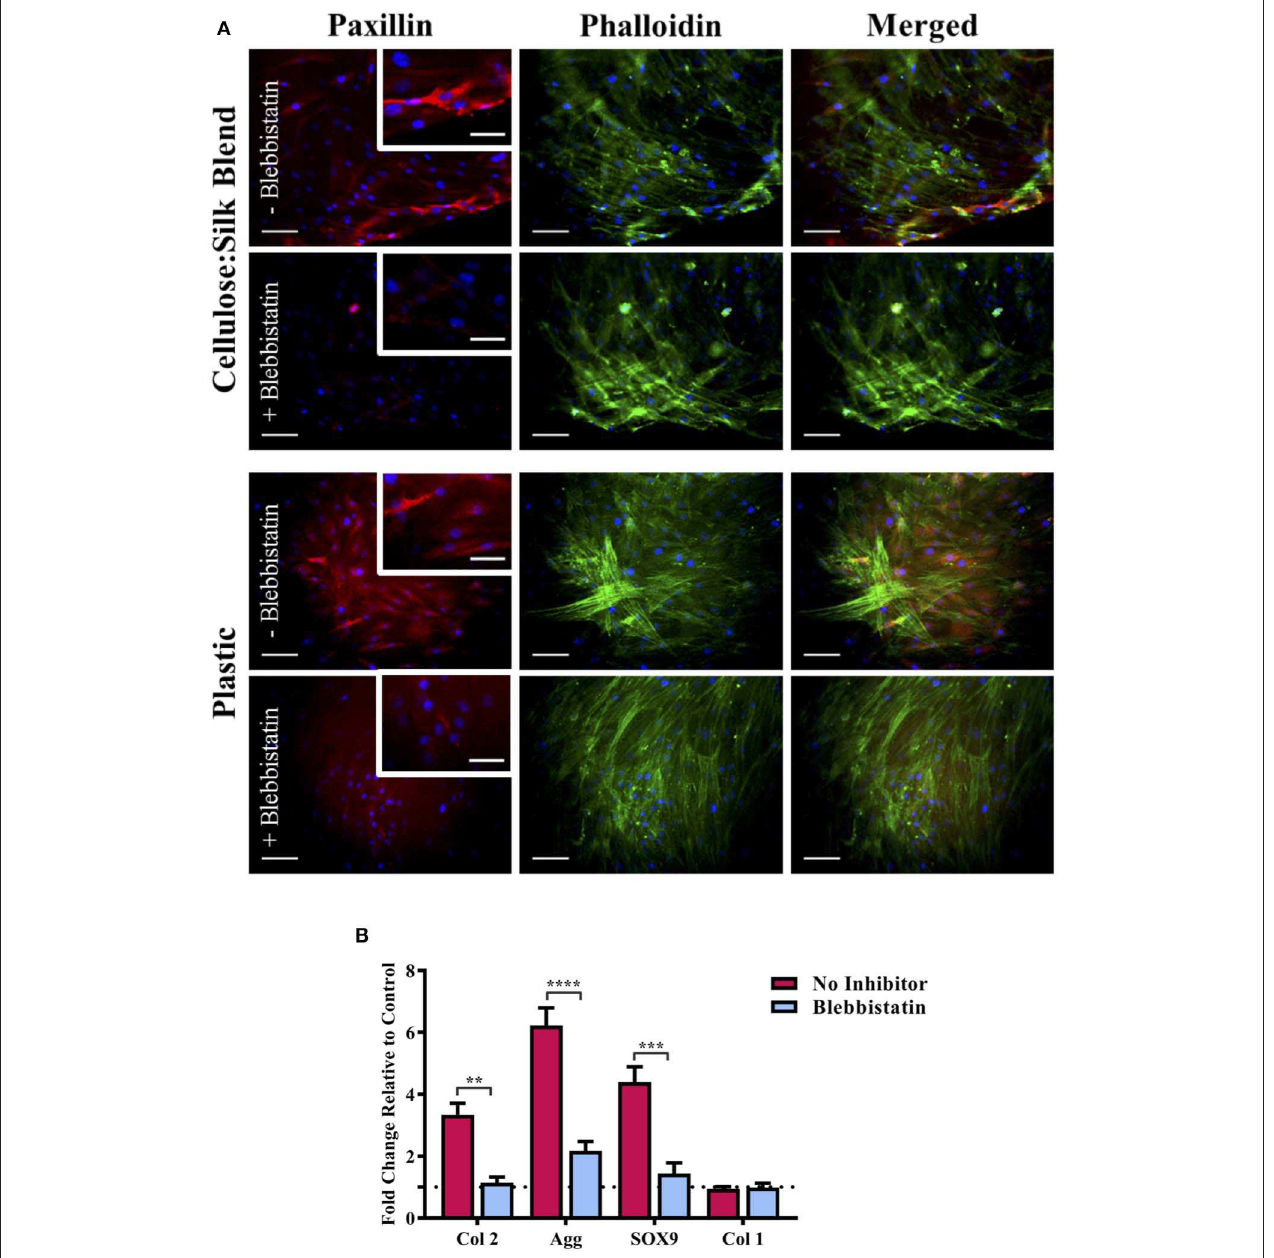
FIGURE 5 | Substrate elasticity and stem cell chondrogenesis. hMSCs were cultured on cellulose:silk 75:25 composite substrates and tissue culture plastic in standard stem cell media supplemented with 10ng/ml FGF-2. (A) Following 3 days culture, cells were fluorescently stained for their focal adhesions (paxillin, red) and cytoskeleton (phalloidin, green) to assess the physical response of cells to their substrate with and without the use of blabbistatin. Cell nuclei are stained using DAPI (blue). Scale bar inset measures 100 µ m. Higher magnification images shown for paxillin staining inset, scale bar measures 50 µ m. (B) Following 14 days of cell culture, gene analysis was performed. Gene expression levels were normalized to expression levels of housekeeping gene, GAPDH (shown in dotted line). Data points show mean ± SE. Statistical differences in gene expression were assessed using a two-way ANOVA with Bonferroni post-test . ** p < 0.01, *** p < 0.001, **** p < 0.0001, n =